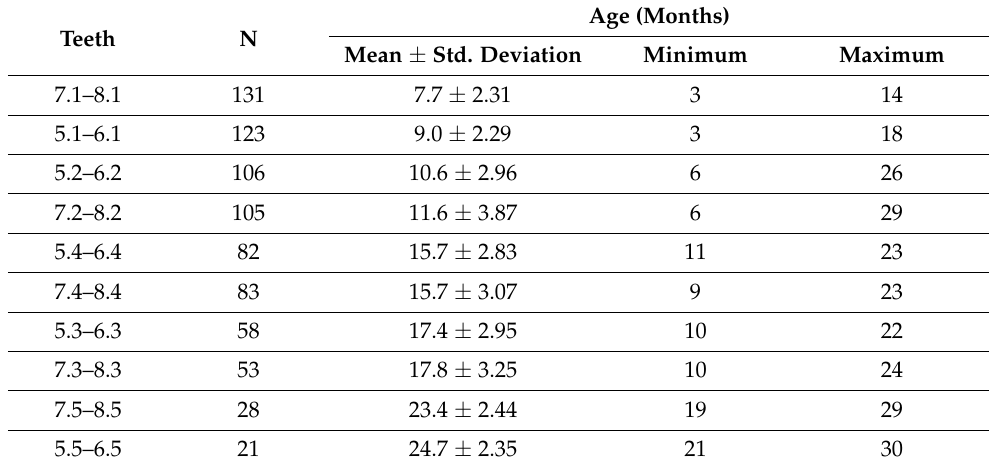
Table 3. The age and sequence of eruption of the groups of two deciduous teeth.